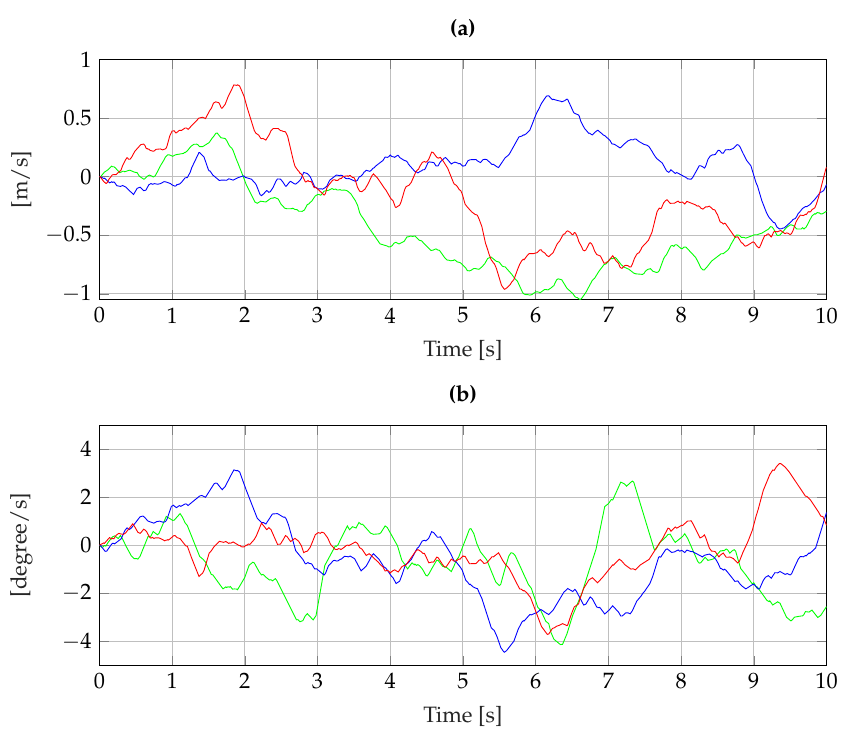
Figure 4. Disturbances for linear and angular velocity: ( a ) d x (green), d y (blue), d z (red), ( b ) δ 1 (green), δ 2 (blue), δ 3 (red)